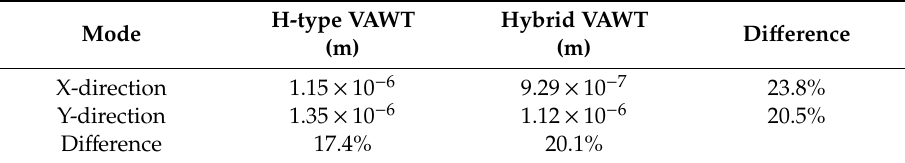
Table 14. Comparison of the maximum steady-state response amplitudes of the 1 m-mast H-type and hybrid VAWTs in X- and Y-directions from their SEMs.